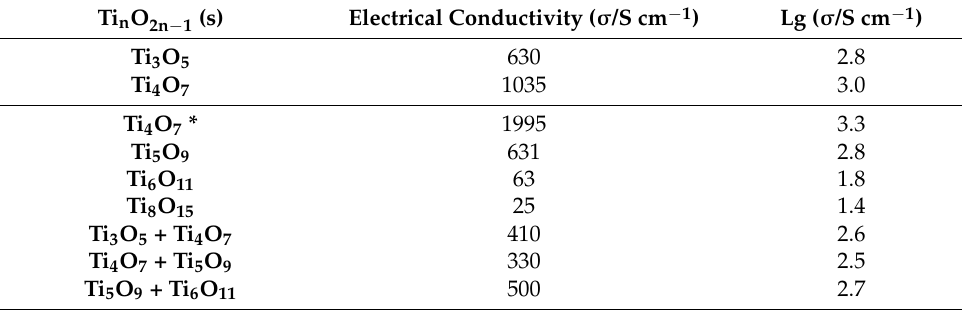
Figure 2. Comparison of crystal structures of TiO 2 and Ti 4 O 7 ( a ); hydrogen and oxygen evolution potentials of some electrode materials (1.0 M H 2 SO 4 ) ( b ) [58]. Table 1. Electrical conductivity of each phase of titanium sub-oxides at 298 K [58].